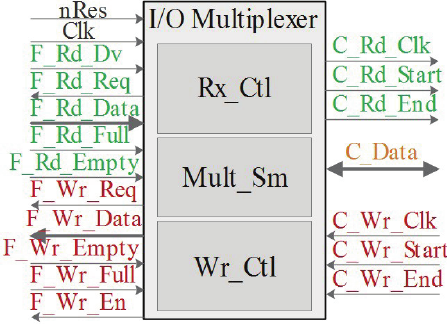
Fig. 7. I/O Multiplexer Logic and Signal